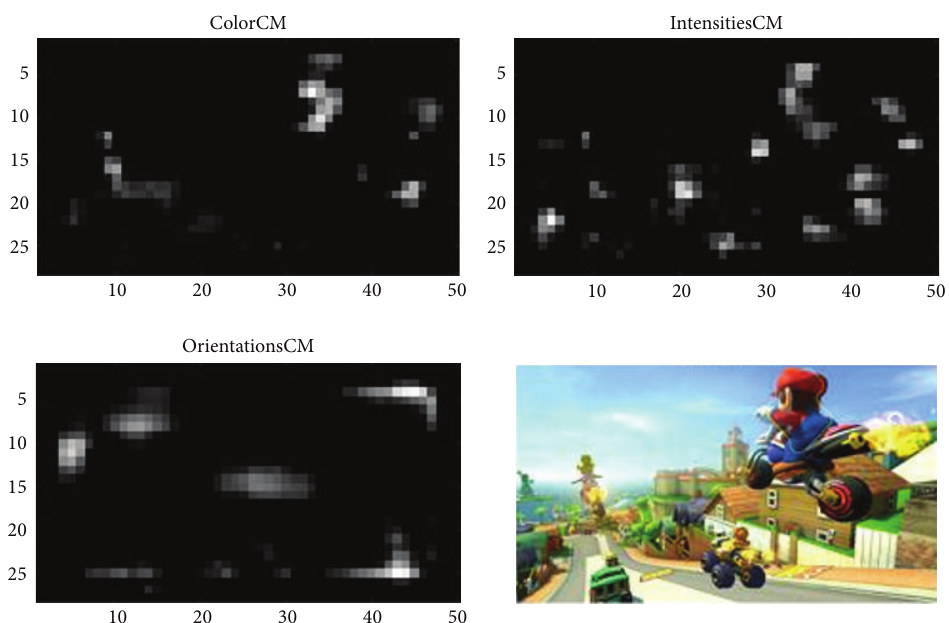
Figure 4: One of the images and its saliency map.